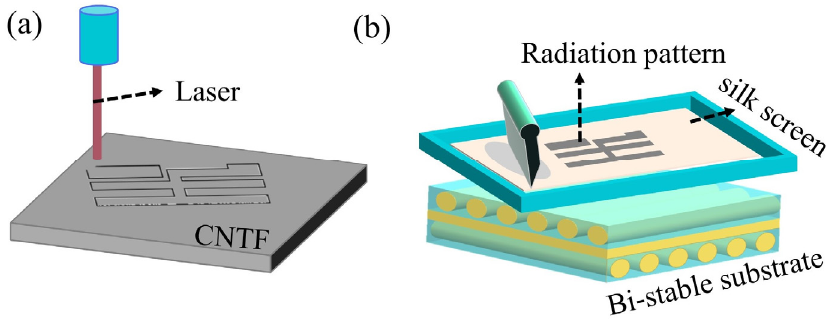
Figure 2. ( a ) Schematic diagram of laser cutting CNTF. ( b ) Schematic diagram of the screen-printing process.